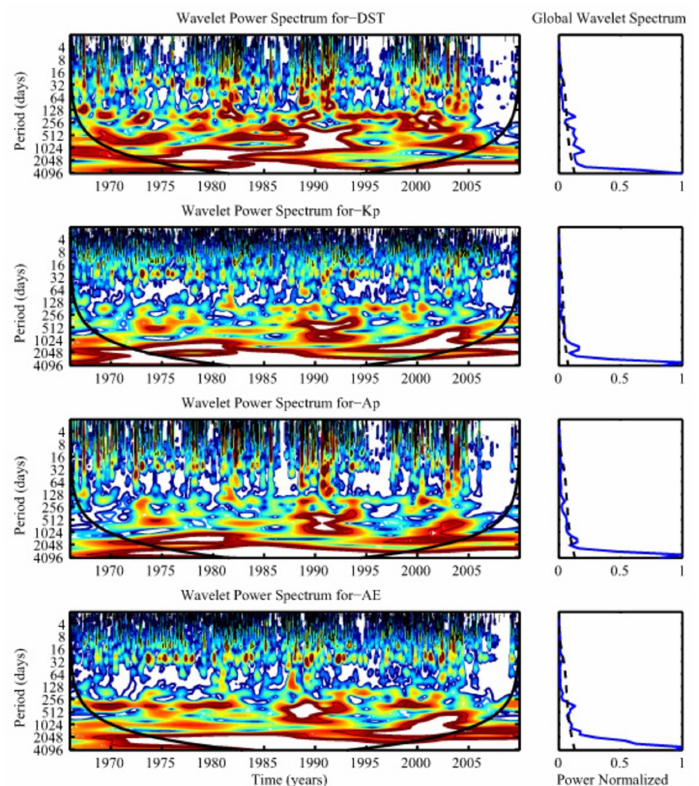
Figure 3. Wavelet spectra and the normalised global wavelet spectra of geomagnetic indices ( top to bottom ): Dst, Kp, Ap and AE (Vsw). The wavelet spectra are colour-coded with red corresponding to the maxima; the black contour is the cone of influence of the spectra, where edge effects in the processing become important. The dashed lines in the global spectra represent a confidence level above 99%. Adapted from Katsavrias et al. 2012